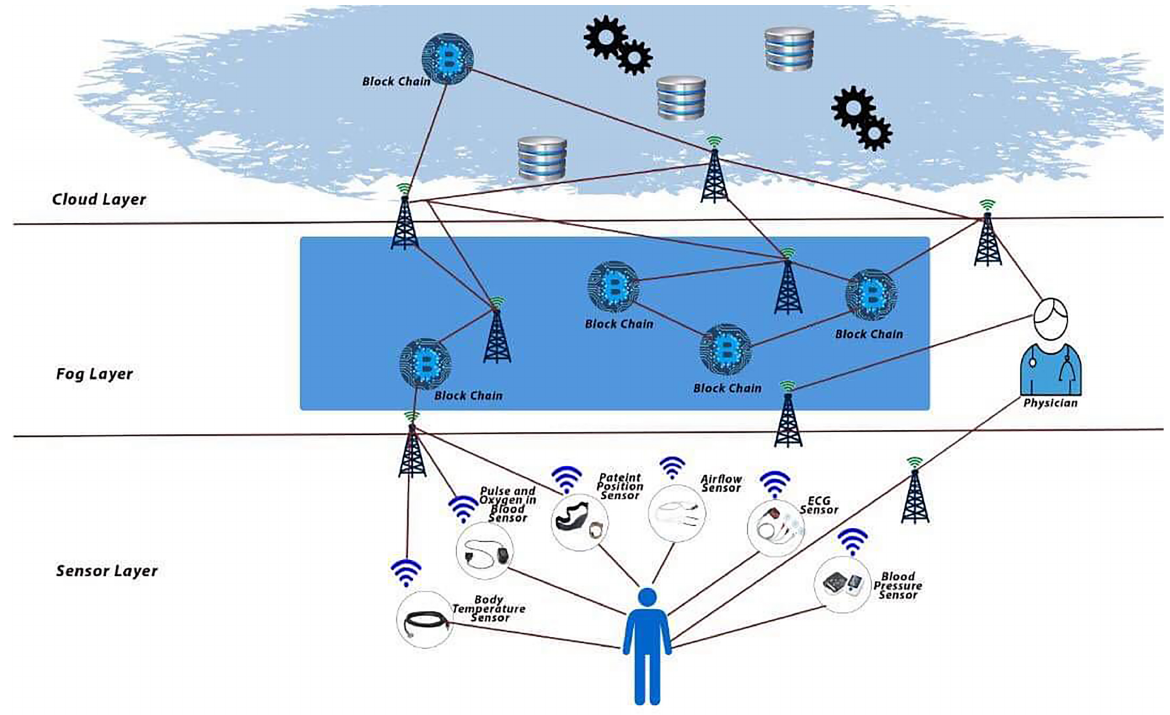
Figure 2. Blockchain-based security model for medical data at the fog